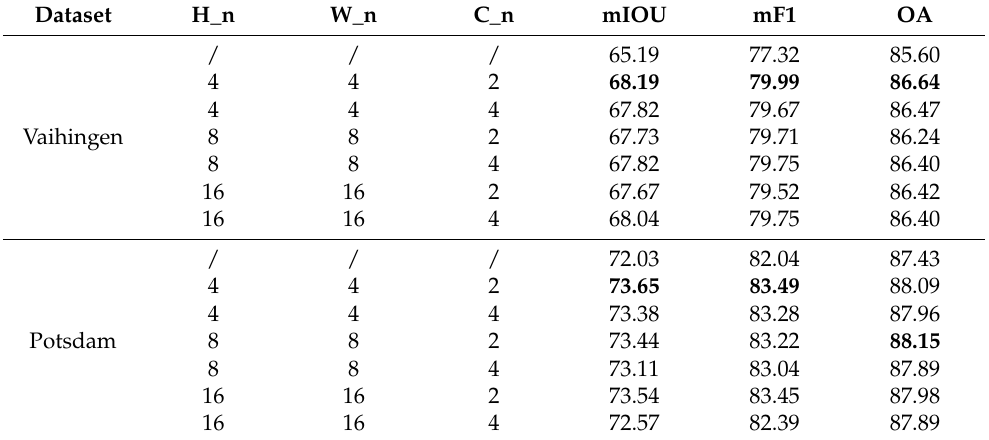
Table 5. Comparisons of different H _ n , W _ n , and C _ n on ISPRS Vaihingen and Potsdam datasets. The best results are shown in boldface.